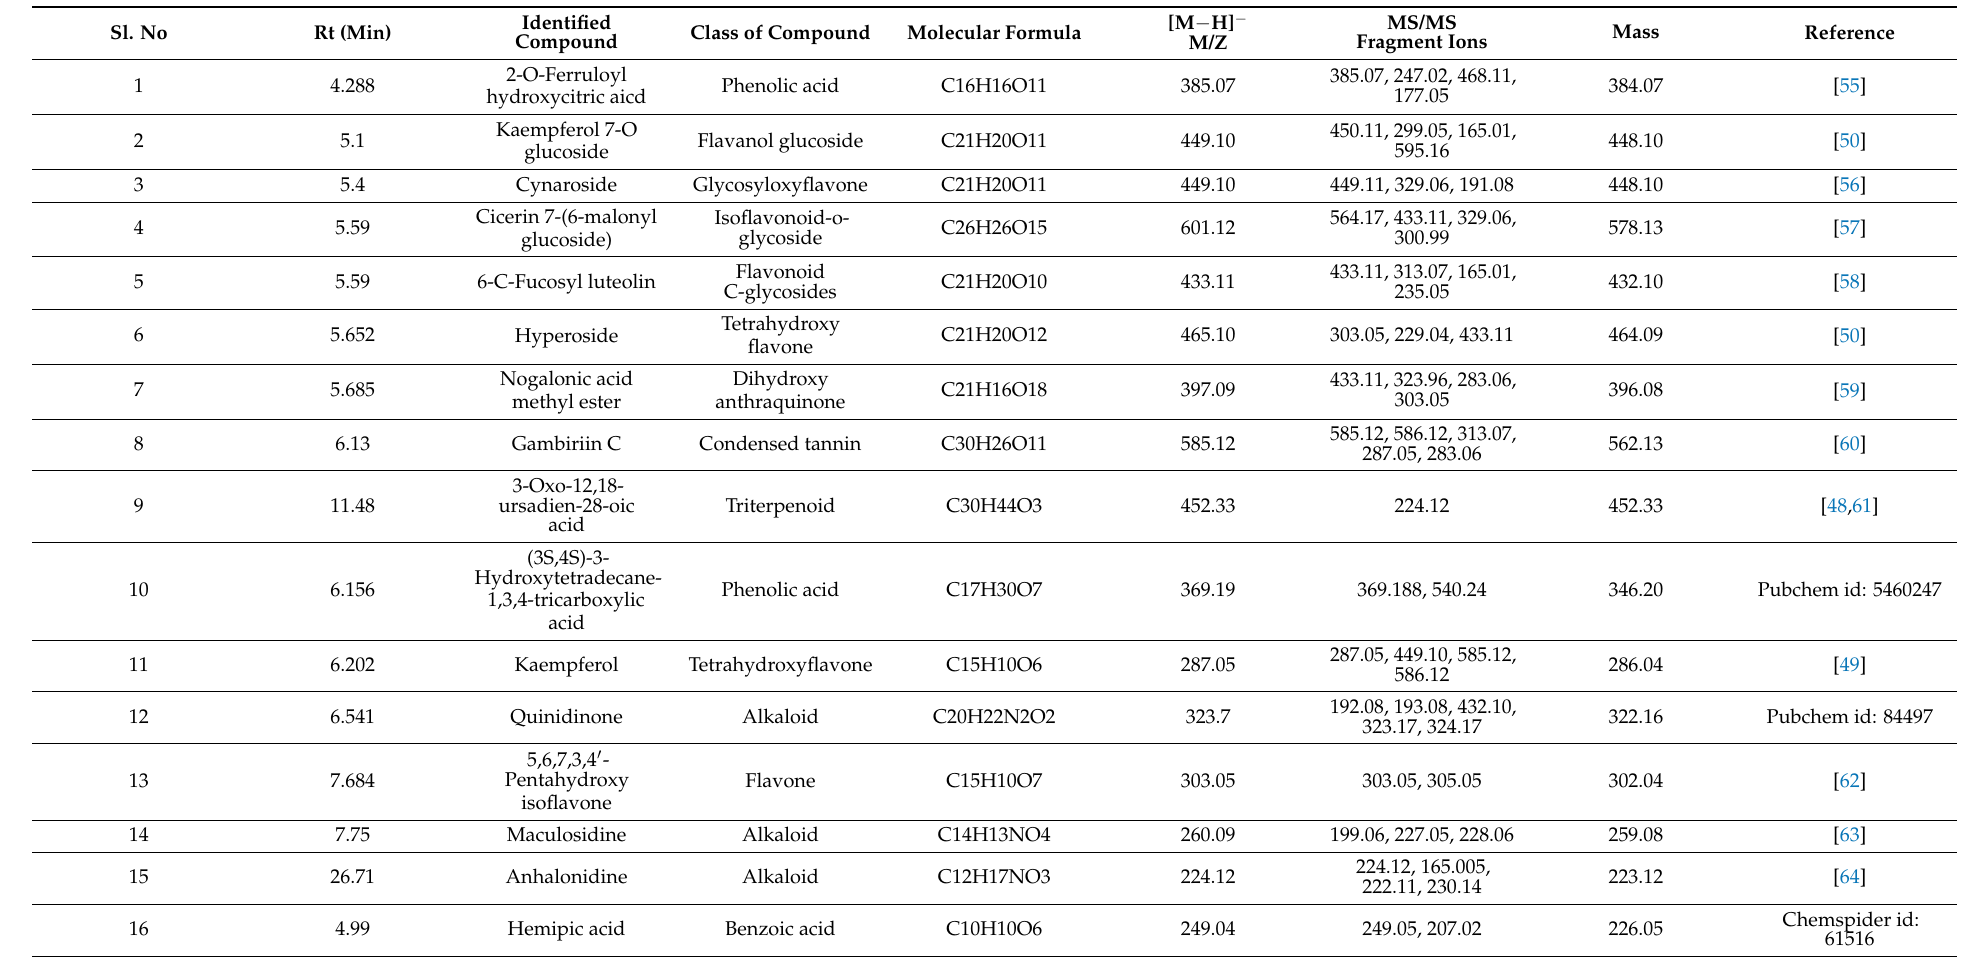
Table 5. Ultrahigh-performance liquid chromatography and MS/MS analysis in positive mode of TCAF2 isolated from the leaf acetone extract of Terminalia catappa